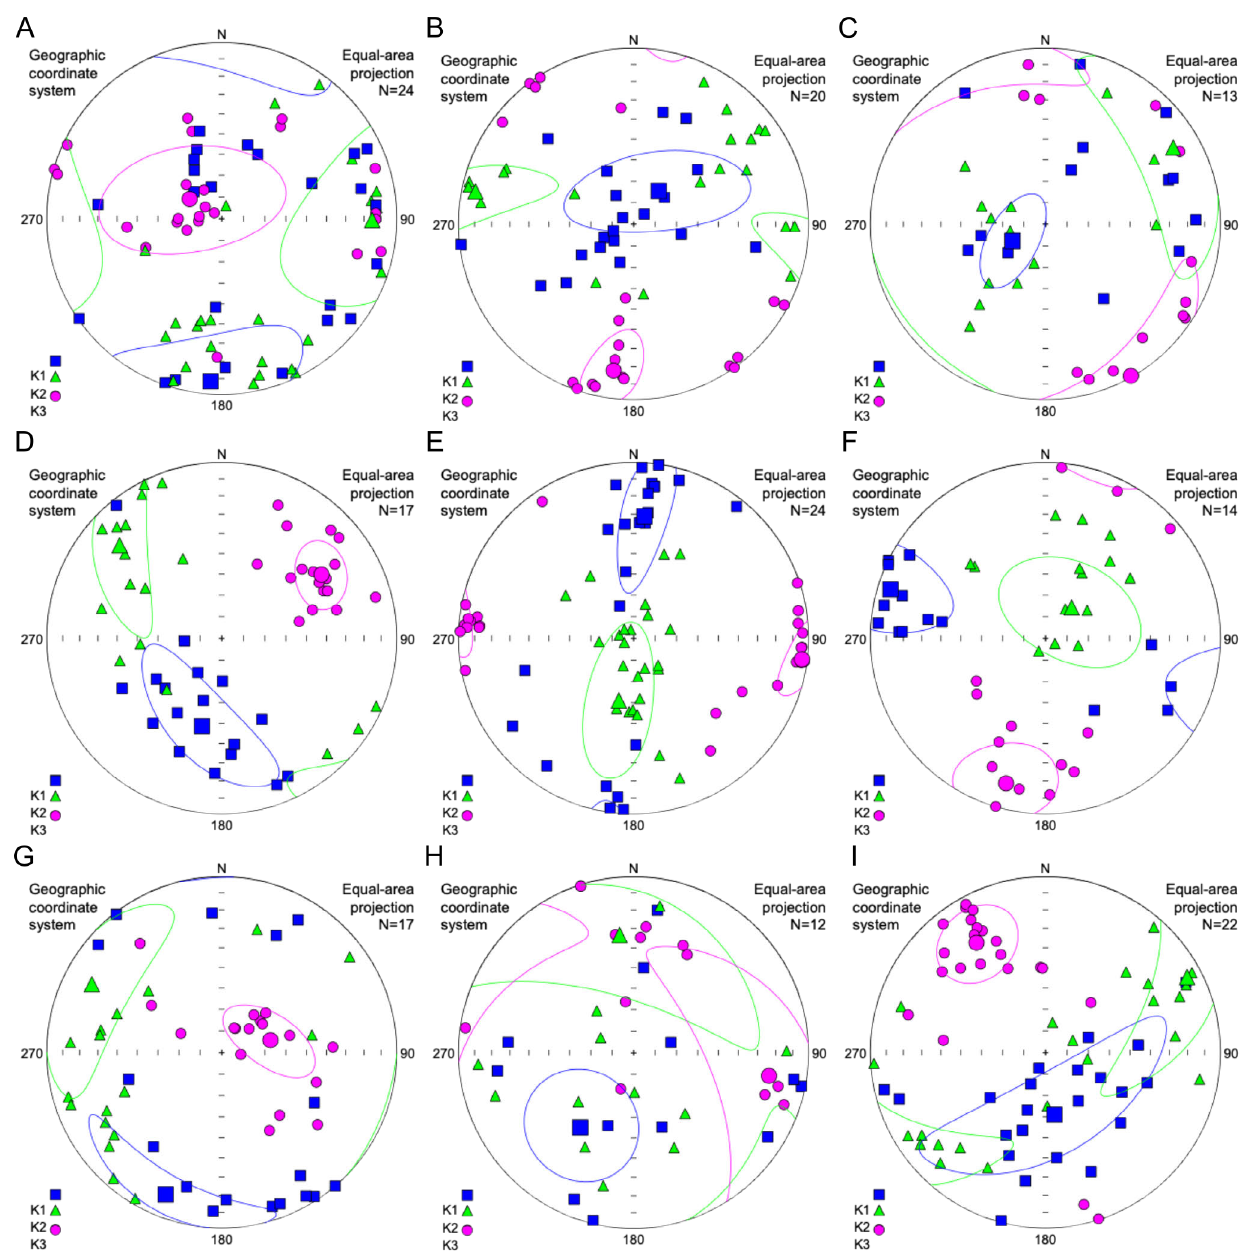
Figure A1: Anisotropy of Magnetic Susceptibility results for [A] PDD1; [B] PDD2; [C] PDD3; [D] PDD4; [E] PDD5; [F] PDD6; [G] PDD7; [H] PDD8; [I]